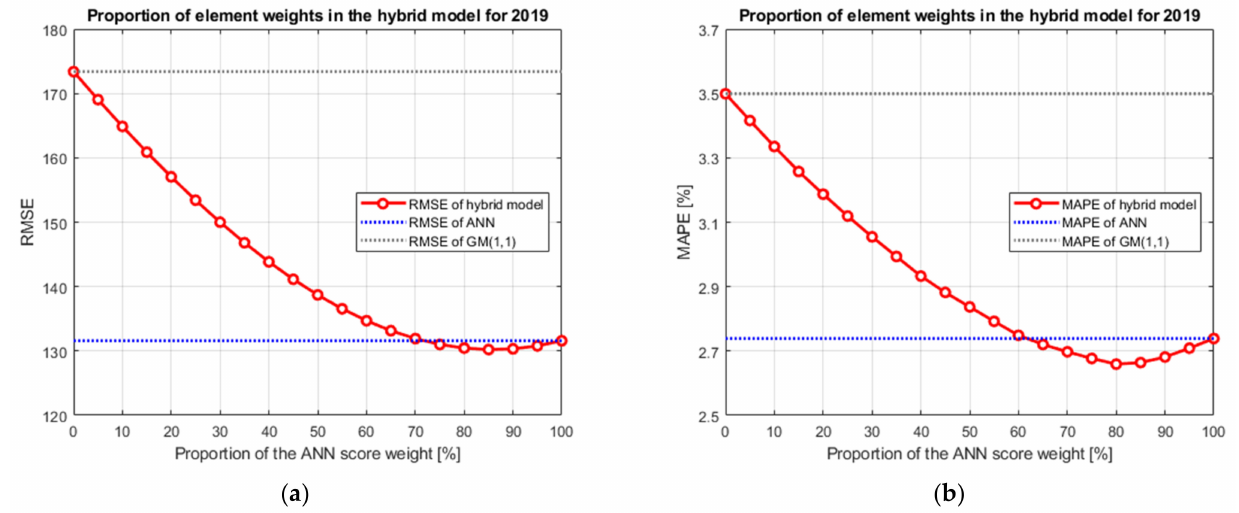
Figure 11. Performance metrics of prediction of potential hybrid models with different weights. ( a ) RMSE of the potential hybrid model for 2019, ( b ) MAPE of the potential hybrid model for